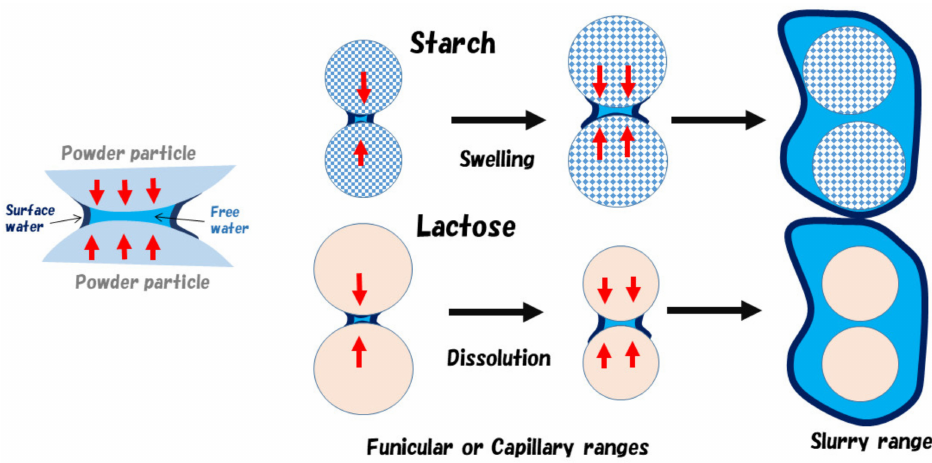
Figure 8. Schematic diagrams of water bridges between the formulation particles in granules during high-speed shear wet granulation